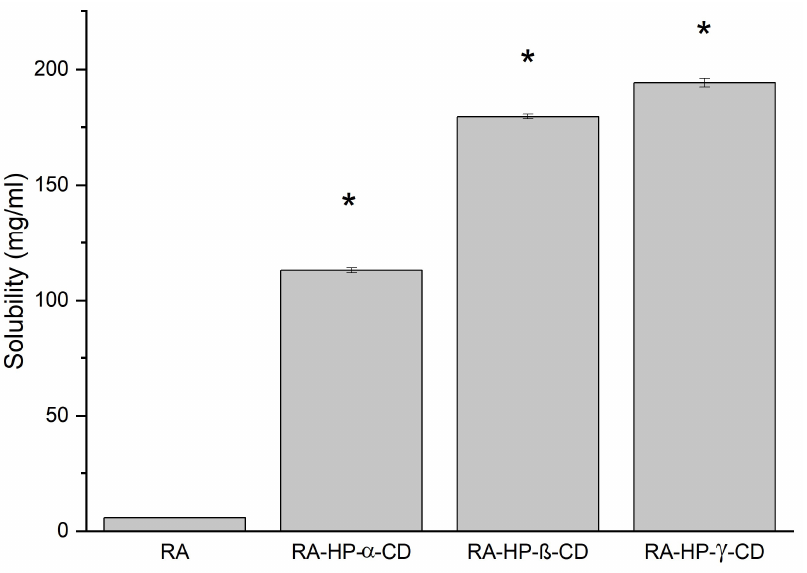
Figure 6. Solubility of RA and RA in binary systems prepared by the solvent evaporation method: RA–HP- α -CD s.e., RA–HP- β -CD s.e., RA–HP- γ -CD s.e. (*) indicates statistically significant differ- ences, p <